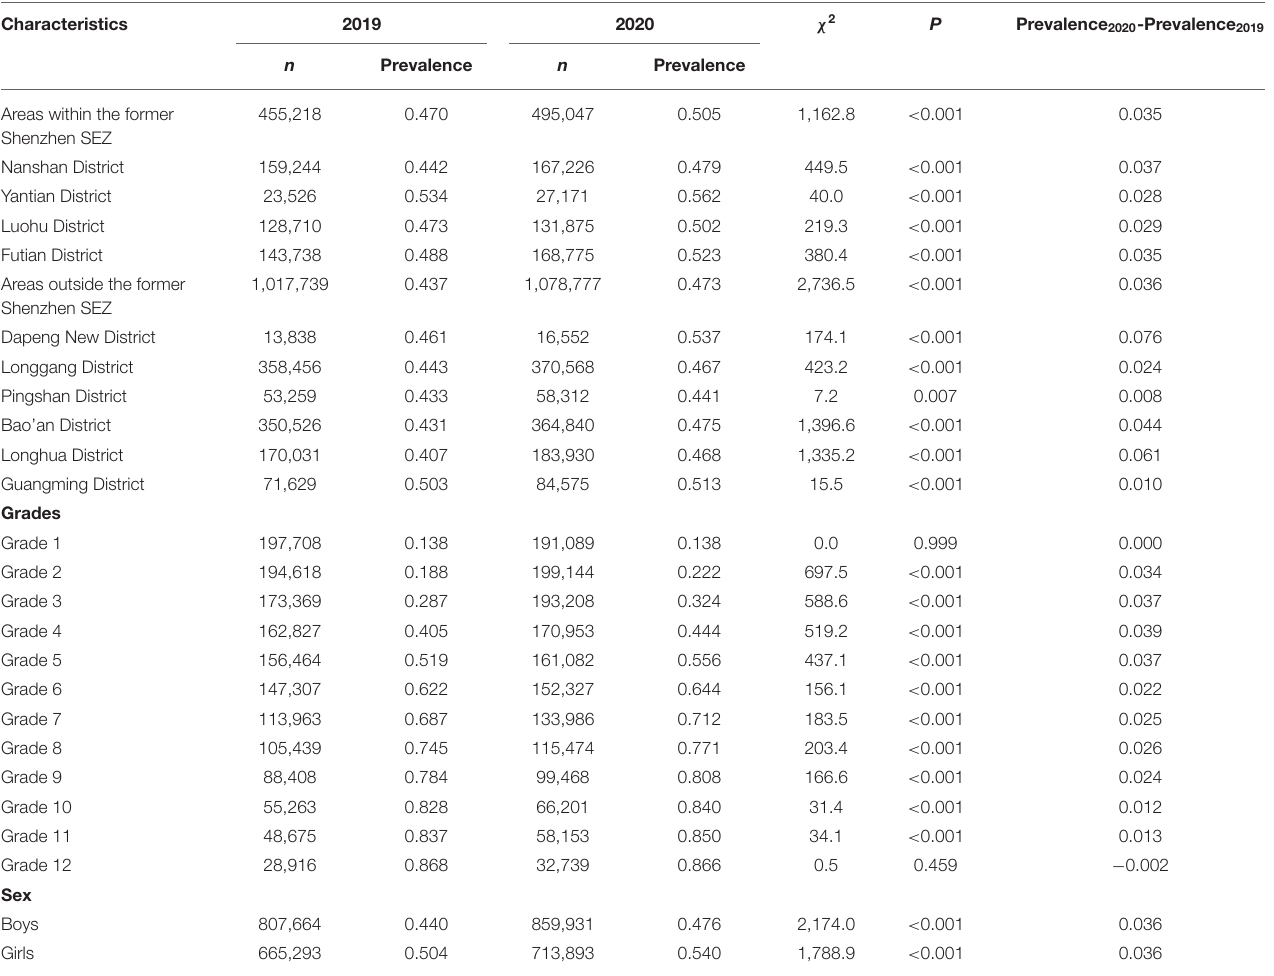
TABLE 1 | The prevalence of myopia among primary and secondary school students in Shenzhen, China according to their demographic characteristics.